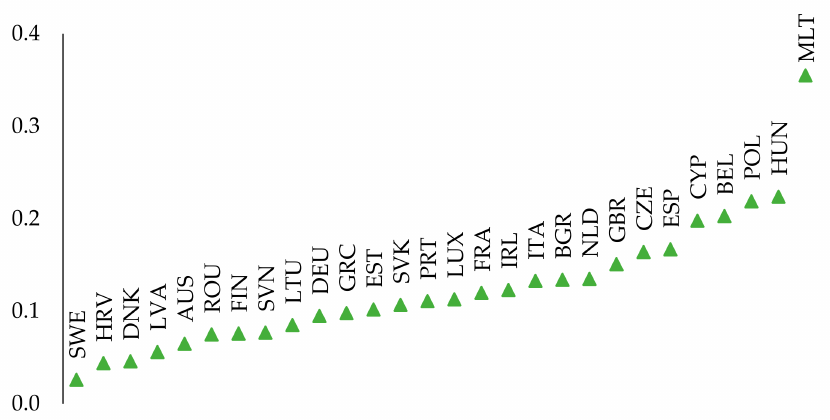
Figure A3. Linear ordering of the EU countries on the basis of the random variation coefficient determined on the basis of linear